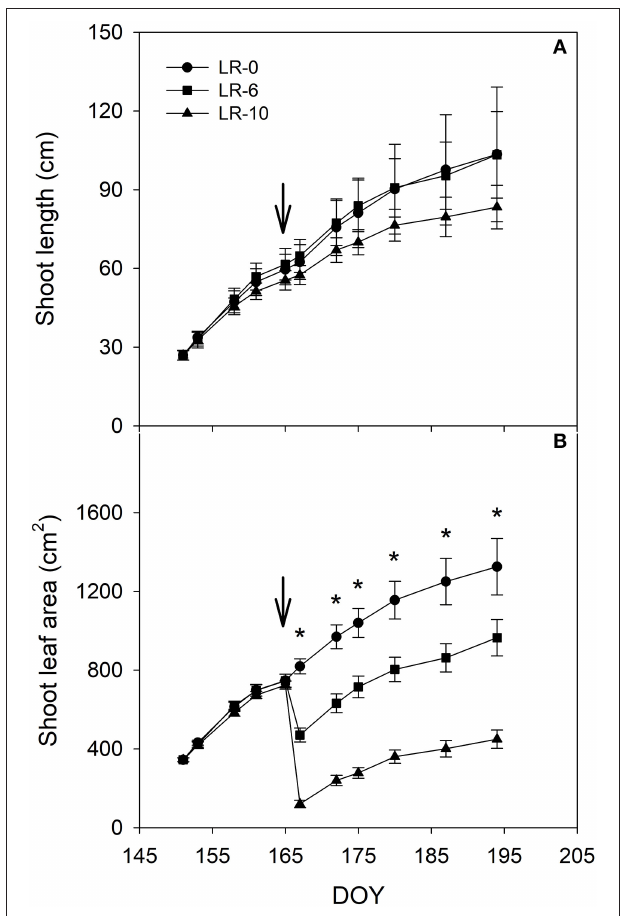
FIGURE 2 | Shoot length (A) and shoot leaf area (main leaves, B ) in relation to different intensity of leaf removal. Each point is the mean of 48 values, vertical bars represent standard errors. The arrow represent grapevine full bloom phenological stage and the time of the leaf removal treatment. Leaf area was measured until the day before canopy trimming on July 14. Symbol (*) represent significant difference at P < 0.05. LR-0, no leaves removed; LR-6, leaves removed from 6 basal nodes; LR-10, leaves removed from 10 basal nodes at bloom; DOY, Day Of